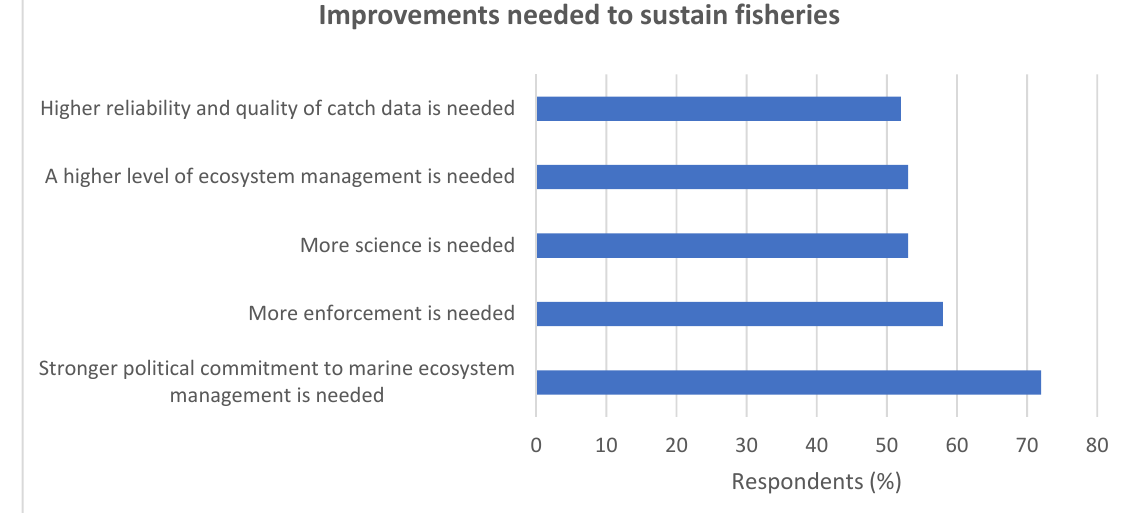
Figure 13. Improvements needed to obtain/maintain sustainable fisheries (n = 165).